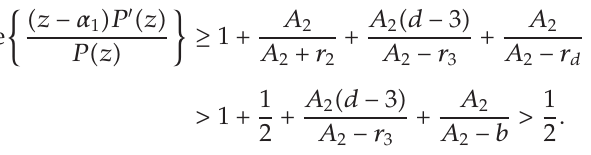
Table 1: Examples of values of M (cid:2) d,y (cid:3) compared to f d (cid:4) M (cid:2) d,y (cid:3) is less than f d is greater than f d / 2 d/ 2 M (cid:2) d,y (cid:3) is greater